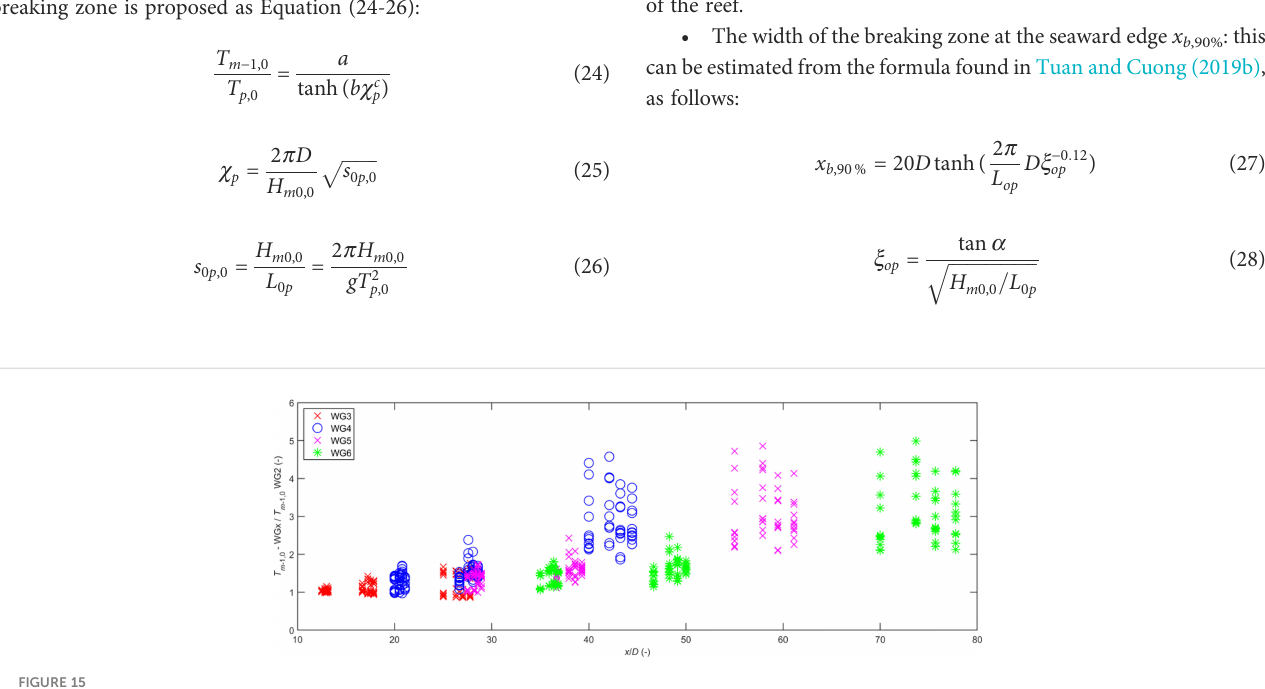
FIGURE 15 Variation in the T m -1,0 period along the submerged